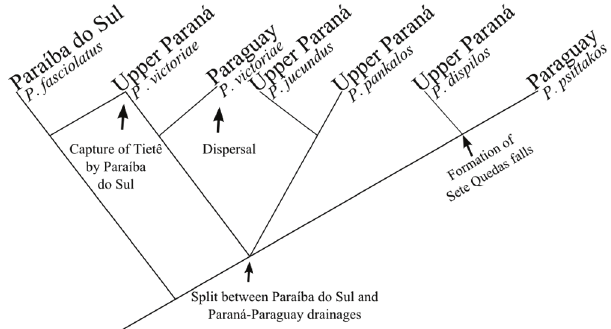
Fig. 5. Areagram showing drainage relationships based on phylogenetic analysis of Phallotorynus (modified from Lucinda et al ., 2005). Arrows indicate major vicariant and dispersion